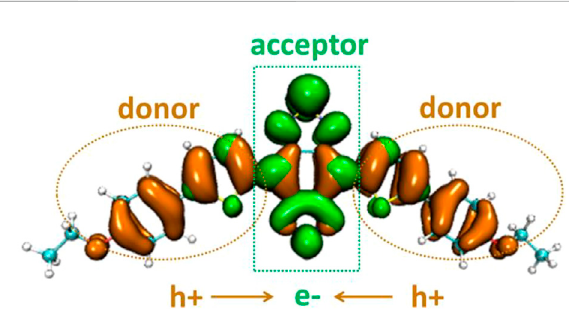
FIGURE 6 Electron distribution difference between S 0 and S 1 of